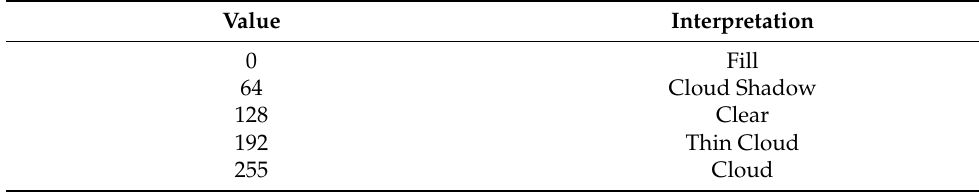
Table 1. Interpretation of the L8 biome dataset cloud mask pixel values [35].